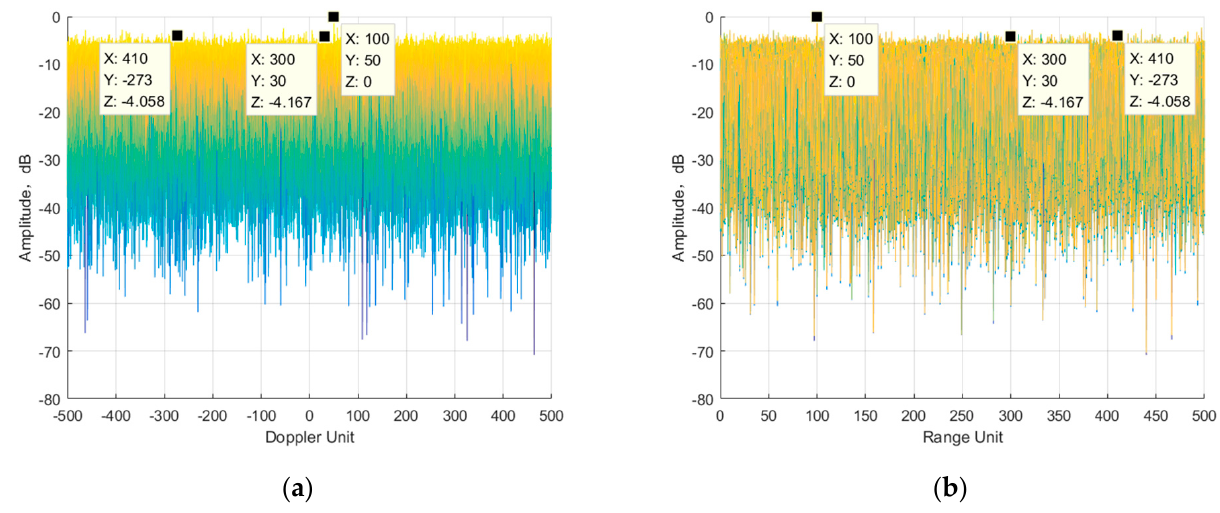
Figure 8. Integration results with traditional R-D processing: N = 2 × 10 4 ; ( a ) Doppler dimension; ( b ) Range dimension.